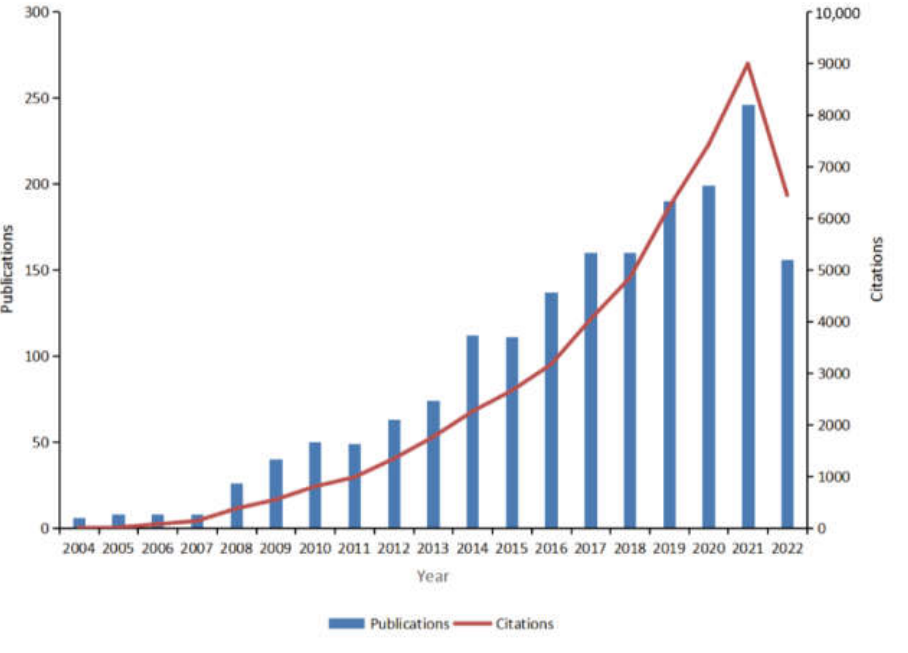
Figure 2. Global trends in publications and total citations for research on comorbidities in psoriasis (2004–2022).